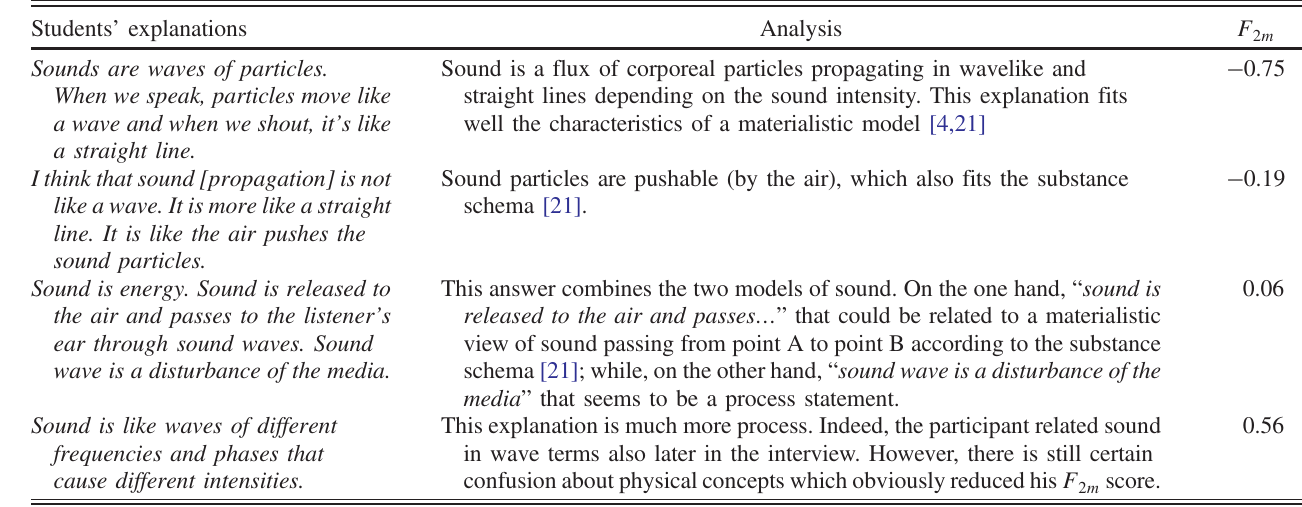
TABLE II. Some examples of students ’ explanations of the sound concept, their short analysis, and appropriate F 2 m values. Students ’